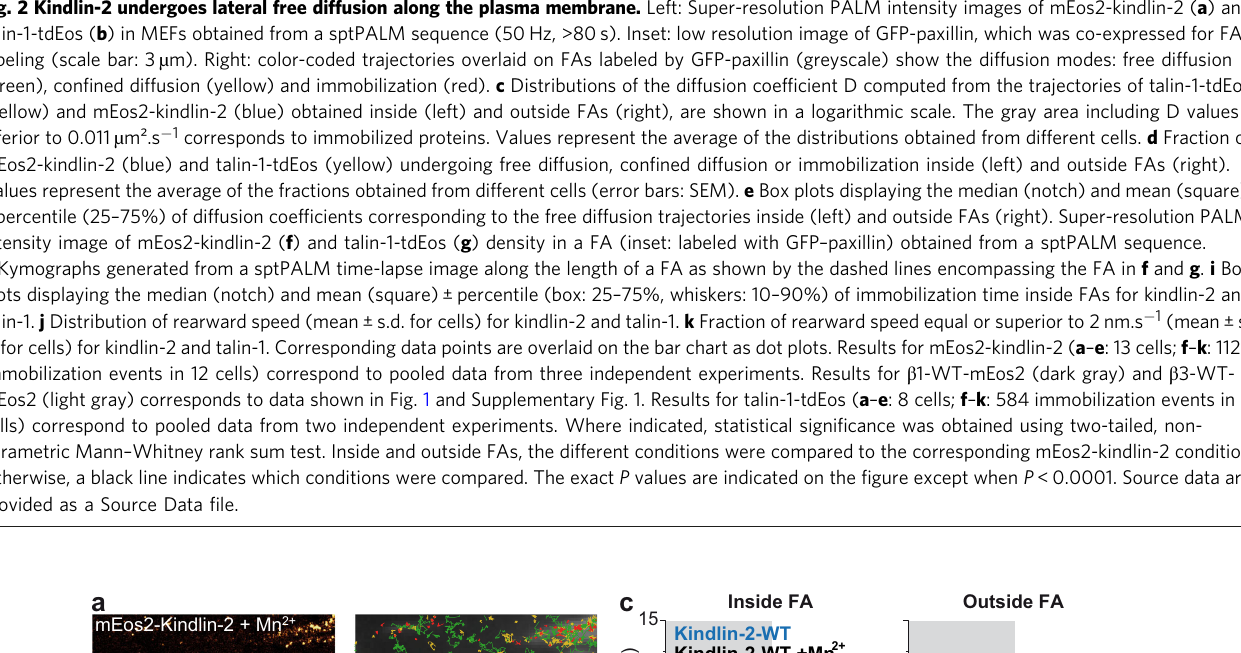
Fig. 2 Kindlin-2 undergoes lateral free diffusion along the plasma membrane. Left: Super ‐ resolution PALM intensity images of mEos2 ‐ kindlin-2 ( a ) and talin-1-tdEos ( b ) in MEFs obtained from a sptPALM sequence (50 Hz, >80 s). Inset: low resolution image of GFP-paxillin, which was co-expressed for FAs labeling (scale bar: 3 µ m). Right: color-coded trajectories overlaid on FAs labeled by GFP-paxillin (greyscale) show the diffusion modes: free diffusion (green), con fi ned diffusion (yellow) and immobilization (red). c Distributions of the diffusion coef fi cient D computed from the trajectories of talin-1-tdEos (yellow) and mEos2 ‐ kindlin-2 (blue) obtained inside (left) and outside FAs (right), are shown in a logarithmic scale. The gray area including D values inferior to 0.011 µ m².s − 1 corresponds to immobilized proteins. Values represent the average of the distributions obtained from different cells. d Fraction of mEos2 ‐ kindlin-2 (blue) and talin-1-tdEos (yellow) undergoing free diffusion, con fi ned diffusion or immobilization inside (left) and outside FAs (right). Values represent the average of the fractions obtained from different cells (error bars: SEM). e Box plots displaying the median (notch) and mean (square) ± percentile (25 – 75%) of diffusion coef fi cients corresponding to the free diffusion trajectories inside (left) and outside FAs (right). Super-resolution PALM intensity image of mEos2-kindlin-2 ( f ) and talin-1-tdEos ( g ) density in a FA (inset: labeled with GFP – paxillin) obtained from a sptPALM sequence. h Kymographs generated from a sptPALM time-lapse image along the length of a FA as shown by the dashed lines encompassing the FA in f and g . i Box plots displaying the median (notch) and mean (square) ± percentile (box: 25 – 75%, whiskers: 10 – 90%) of immobilization time inside FAs for kindlin-2 and talin-1. j Distribution of rearward speed (mean ± s.d. for cells) for kindlin-2 and talin-1. k Fraction of rearward speed equal or superior to 2 nm.s − 1 (mean ± s. d. for cells) for kindlin-2 and talin-1. Corresponding data points are overlaid on the bar chart as dot plots. Results for mEos2 ‐ kindlin-2 ( a – e : 13 cells; f – k : 1127 immobilization events in 12 cells) correspond to pooled data from three independent experiments. Results for β 1-WT-mEos2 (dark gray) and β 3-WT- mEos2 (light gray) corresponds to data shown in Fig. 1 and Supplementary Fig. 1. Results for talin-1-tdEos ( a – e : 8 cells; f – k : 584 immobilization events in 7 cells) correspond to pooled data from two independent experiments. Where indicated, statistical signi fi cance was obtained using two ‐ tailed, non ‐ parametric Mann – Whitney rank sum test. Inside and outside FAs, the different conditions were compared to the corresponding mEos2 ‐ kindlin-2 condition Otherwise, a black line indicates which conditions were compared. The exact P values are indicated on the fi gure except when P < 0.0001. Source data are provided as a Source Data fi le.